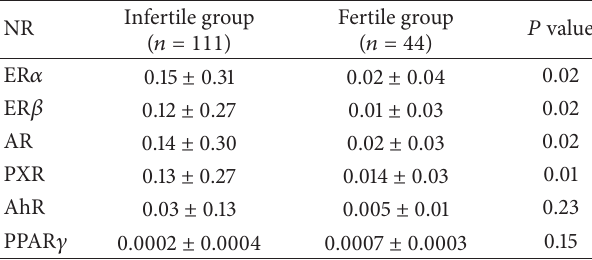
Table 2: Cellular gene expression level of nuclear receptors in infer- tile and fertile women.